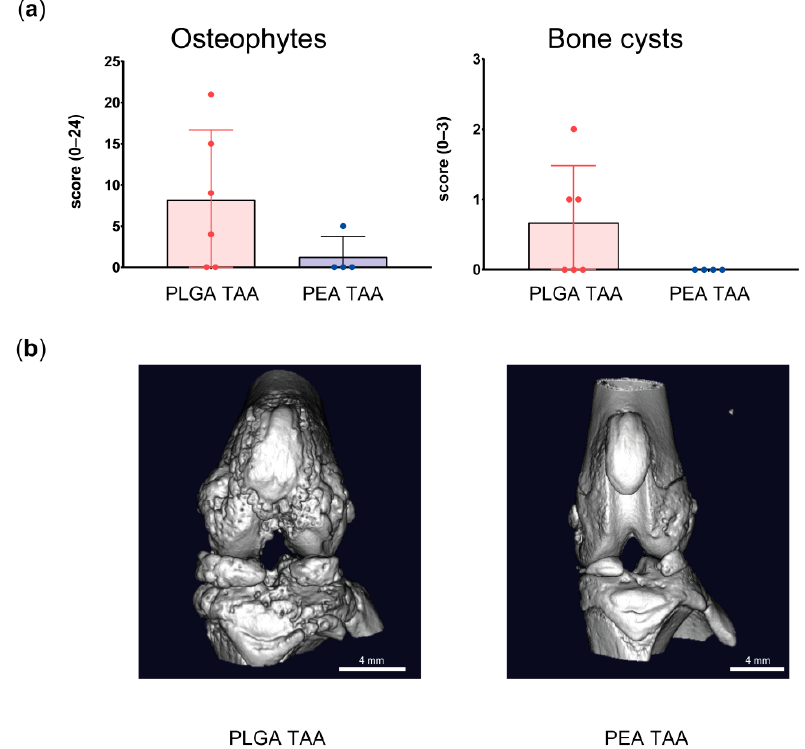
Figure 8. Post mortem imaging of bone changes in joints treated with TAA-loaded PLGA and PEA microspheres. (a) Osteophyte and bone cyst formation in the affected ipsilateral knee joints of animals treated with TAA-loaded PLGA microspheres (red) or TAA-loaded PEA microspheres (blue). Data are presented as mean ± standard deviation (SD). (b) 3D µCT images of the affected joints treated with TAA-loaded PLGA microspheres (left) and PEA microspheres (right).